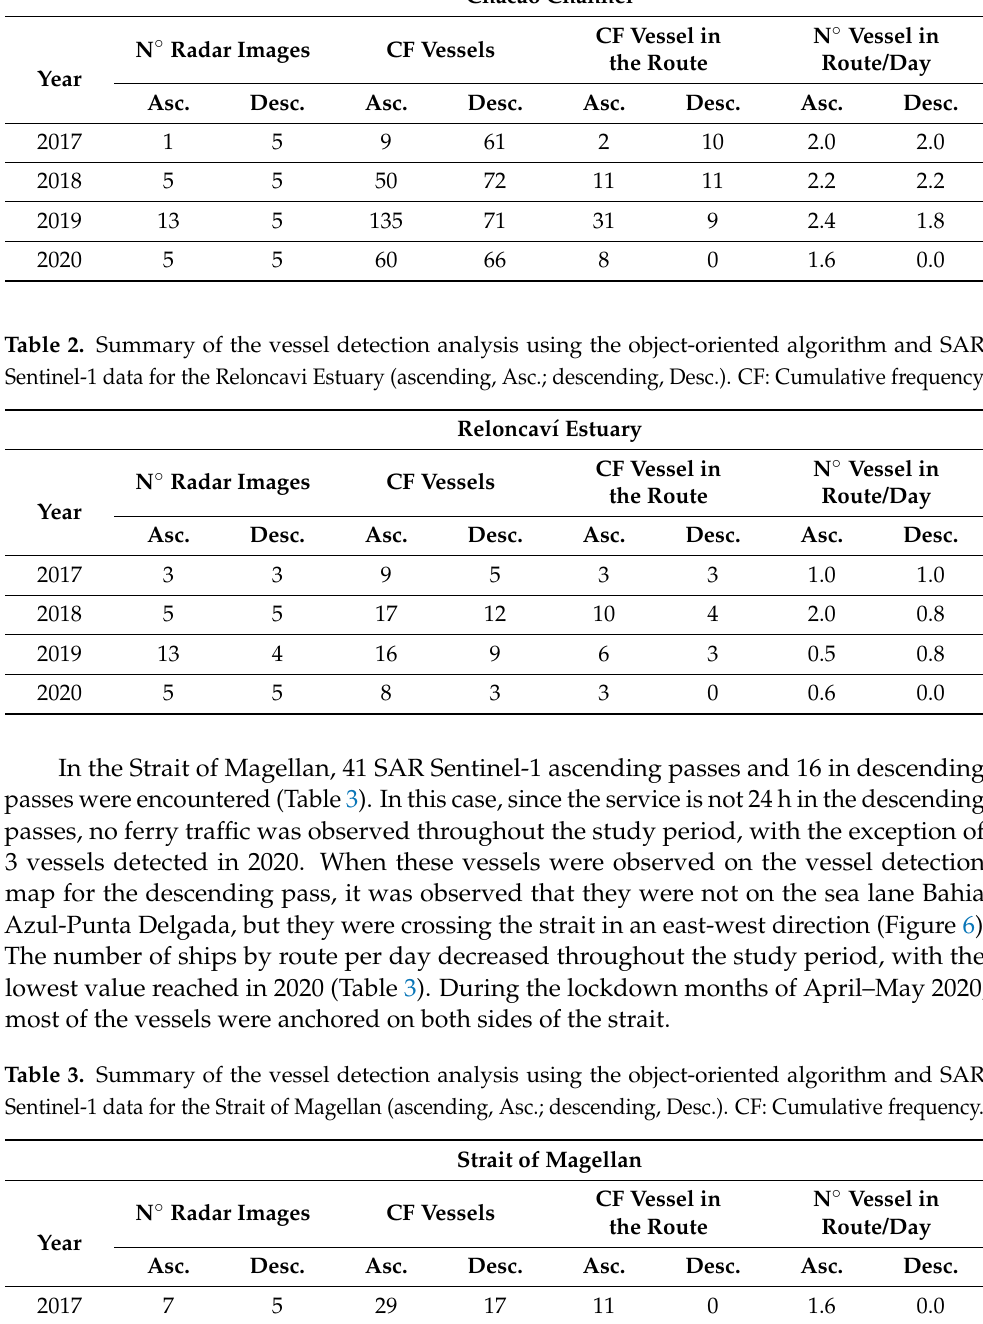
Table 1. Summary of the vessel detection analysis using object-oriented algorithm and synthetic aperture radar (SAR) Sentinel-1 data for the Chacao Channel (ascending, Asc.; descending, Desc.). CF: Cumulative frequency. Chacao Channel N ◦ Radar Images